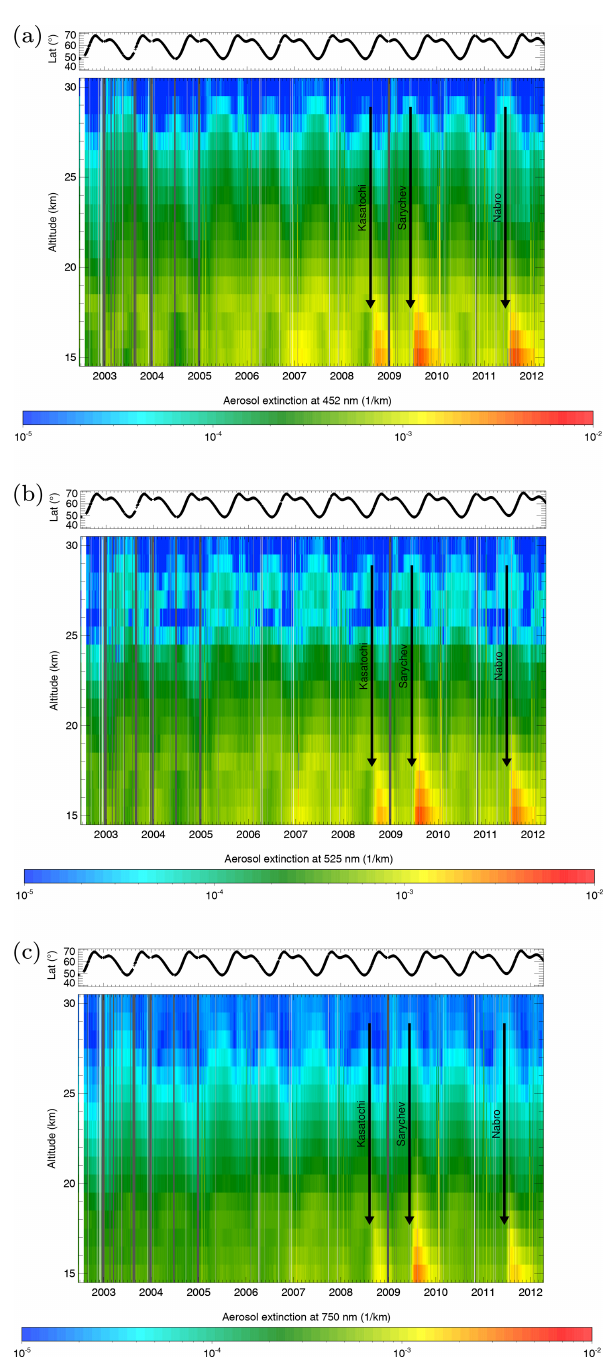
Figure 13. Time series of daily gridded aerosol extinction profiles from SCIAMACHY solar occultation at (a–c) 452, 525 and 750nm. The start times of some major volcanic eruptions occurring at higher latitudes are marked. At the top of each panel, the mean latitude of the observations is shown. Grey vertical bars in each panel de- note times of degraded instrument performance (e.g. decontamina- tion periods or switch-offs).